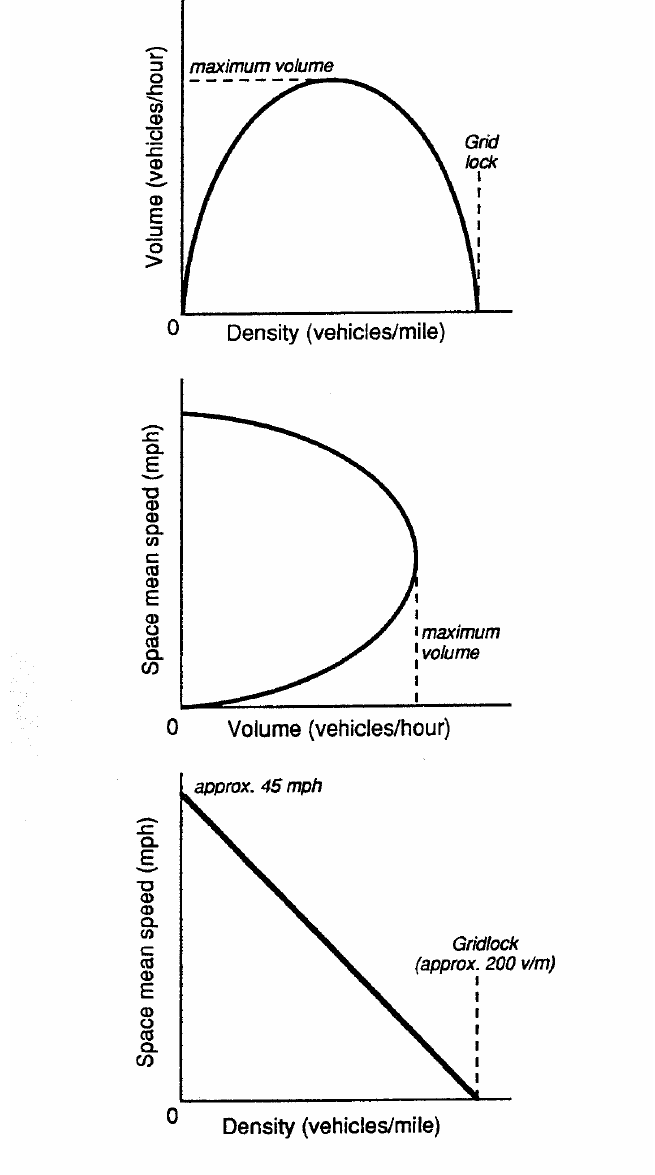
Figure 1. The fundamental diagram of traffic (after Black,